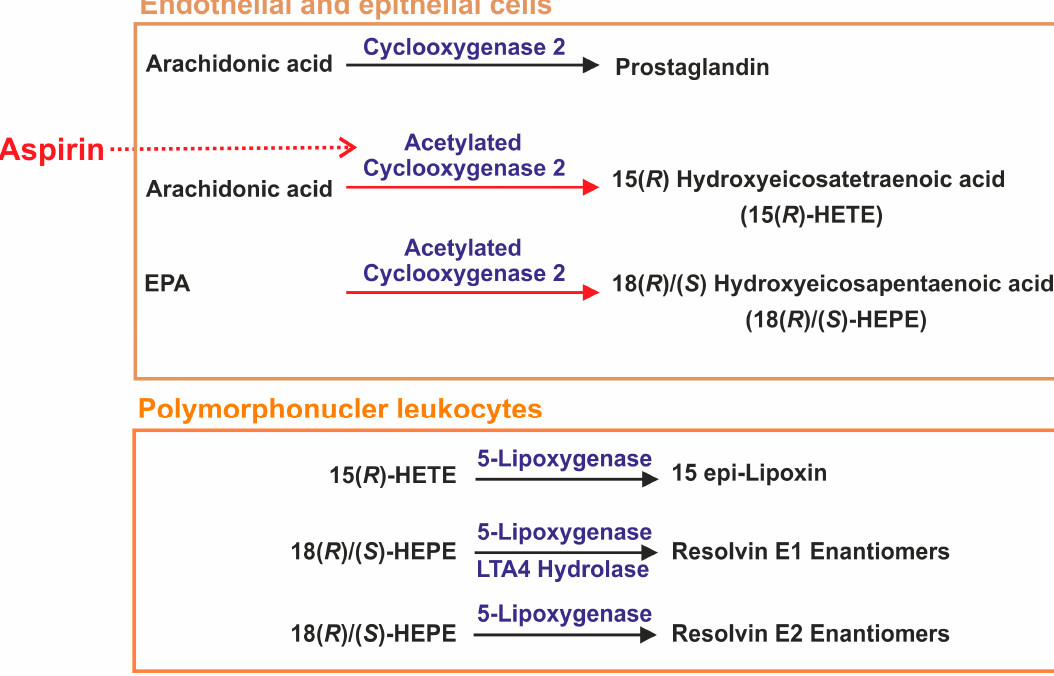
Figure 4. Aspirin-triggered pro-resolving lipids. Aspirin-acetylated cyclooxygenase 2 synthesizes 15( R )-hydroxyeicosatetraenoic acid from arachidonic acid and 18( S )- and 18( R )-hydroxyeicosapentaenoic acid from eicosapentaneoic acid (EPA). These lipids are released from endothelial and epithelial cells and are taken up by polymorphonuclear leukocytes. Here, they are converted to 15-epi-lipoxin, resolvin E1 and resolvin E2 by 5-lipoxygenase. For resolvin E1 synthesis, leukotriene A4 (LTA4) hydrolase is also needed.